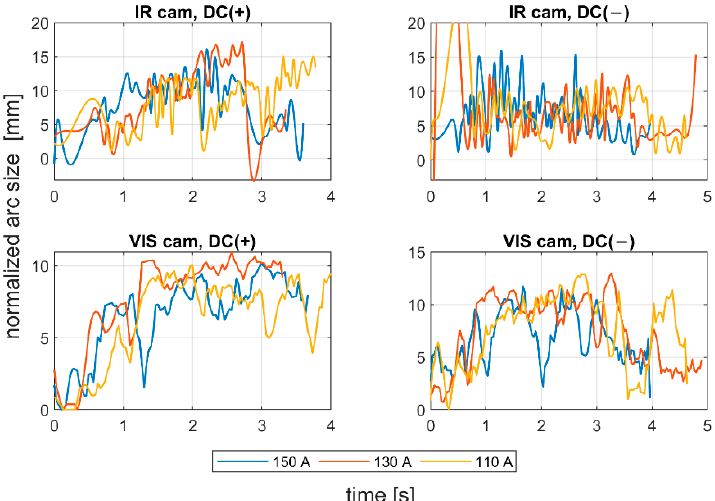
Figure 7. Comparison of normalized arc size, being the squared root of the minor and major axis length product of the ellipse, having the same second moment as the welding arc ROI for positive and negative polarity. For VIS CAM, the signal was averaged; for IR CAM, the signal peak envelope was calculated.